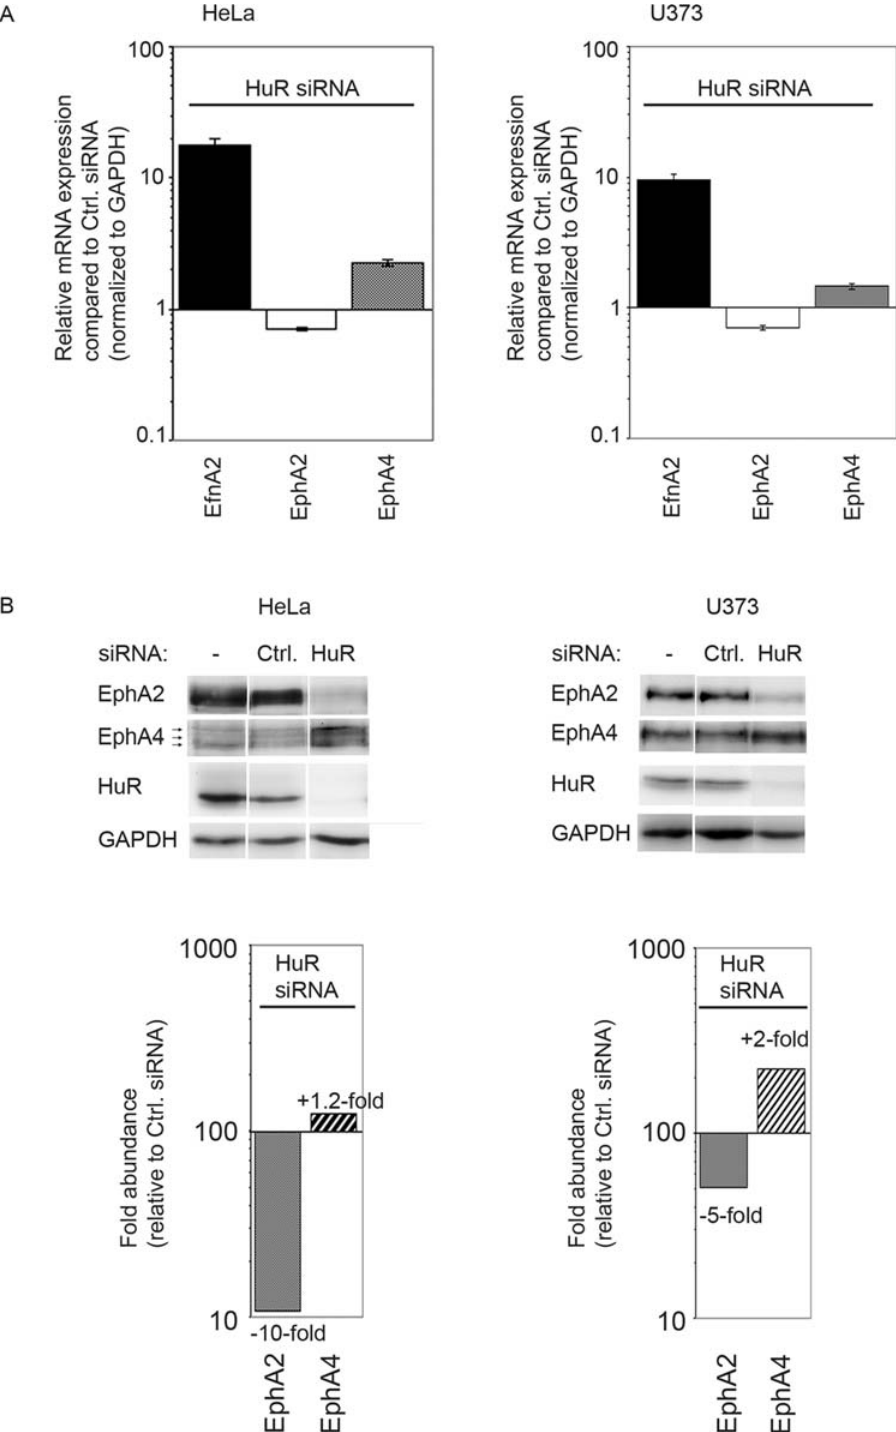
Figure 6. HuR regulates expression of Eph/ephrins. HuR was knocked down with a specific HuR RNAi oligonucleotide in HeLa and U373 cells (A) mRNA expression of EfnA2, EphA2 and EphA4 72 hours after transfection of a specific HuR RNAi oligo was compared to transfection of a non- silencing control oligo as measured by Real Time RT-PCR. Ratios between expression levels after HuR knockdown and tranfection of non-silencing control oligonucleotodides are shown. Values were normalized to GAPDH. (B) Westernblot analyses of protein expression of EphA2, EphA4 (three isoforms, see arrows), HuR and GAPDH 72 hours after knockdown of HuR (upper panel, lane 3) with specific antibodies in comparison to a mock- control (lane 1) as well as a non-silencing siRNA control (lane 2). Quantification of bands (Against GAPDH) was performed using the Image Quant software 5.2 (lower panel). Fold increase or decrease of expression are depicted.